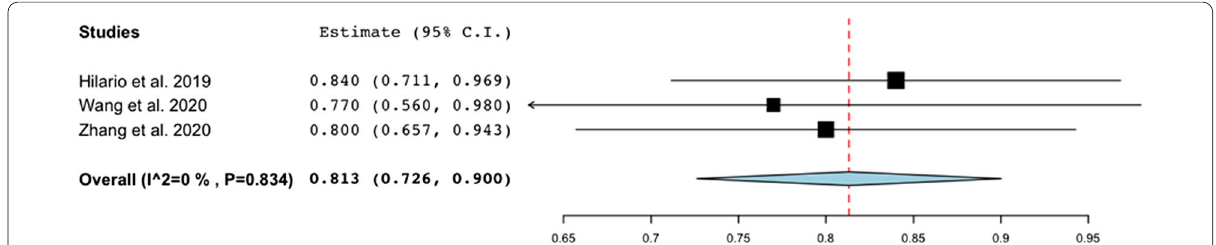
Fig. 2 Forest-plot of the area under the curve (AUC) of the receiver operator curve (ROC) of the different perfusion metrics in predicting IDH mutation status. IDH, isocitrate dehydrogenase, ktrans, volume transfer coefficient; rCBV, relative cerebral blood volume; Ve, fractional volume of the extravascular extracellular space; Vp, fractional blood plasma volume; 95%-CI, 95%-confidence